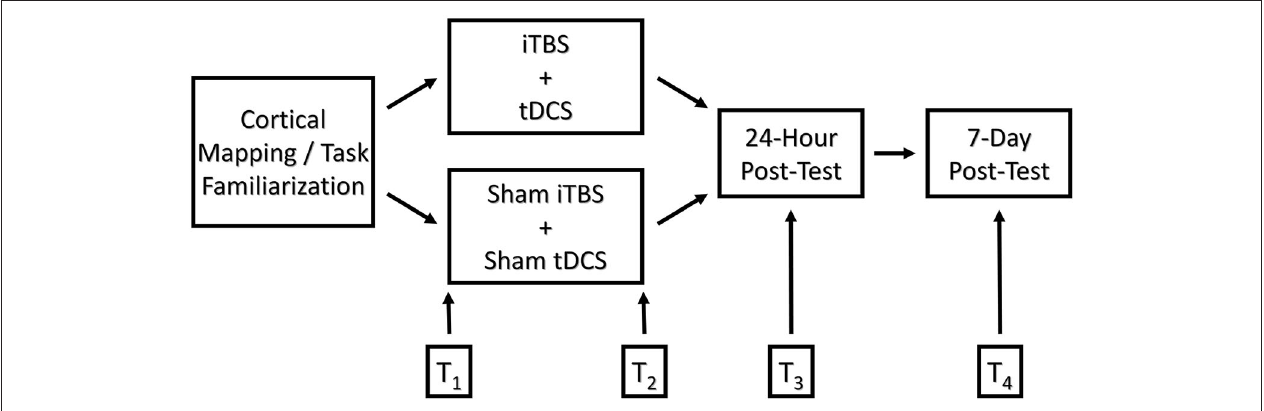
represent time points at which motor skill performance was measured: T 1 = pre-test, T 2 = immediate post-test, T 3 = 24-h post-test, and T 4 = 7-days post-test,